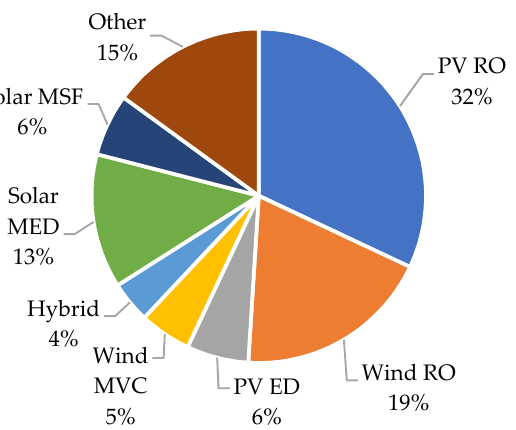
Figure 6. Desalination techniques fed by renewable energy sources in 2017, data from [50].